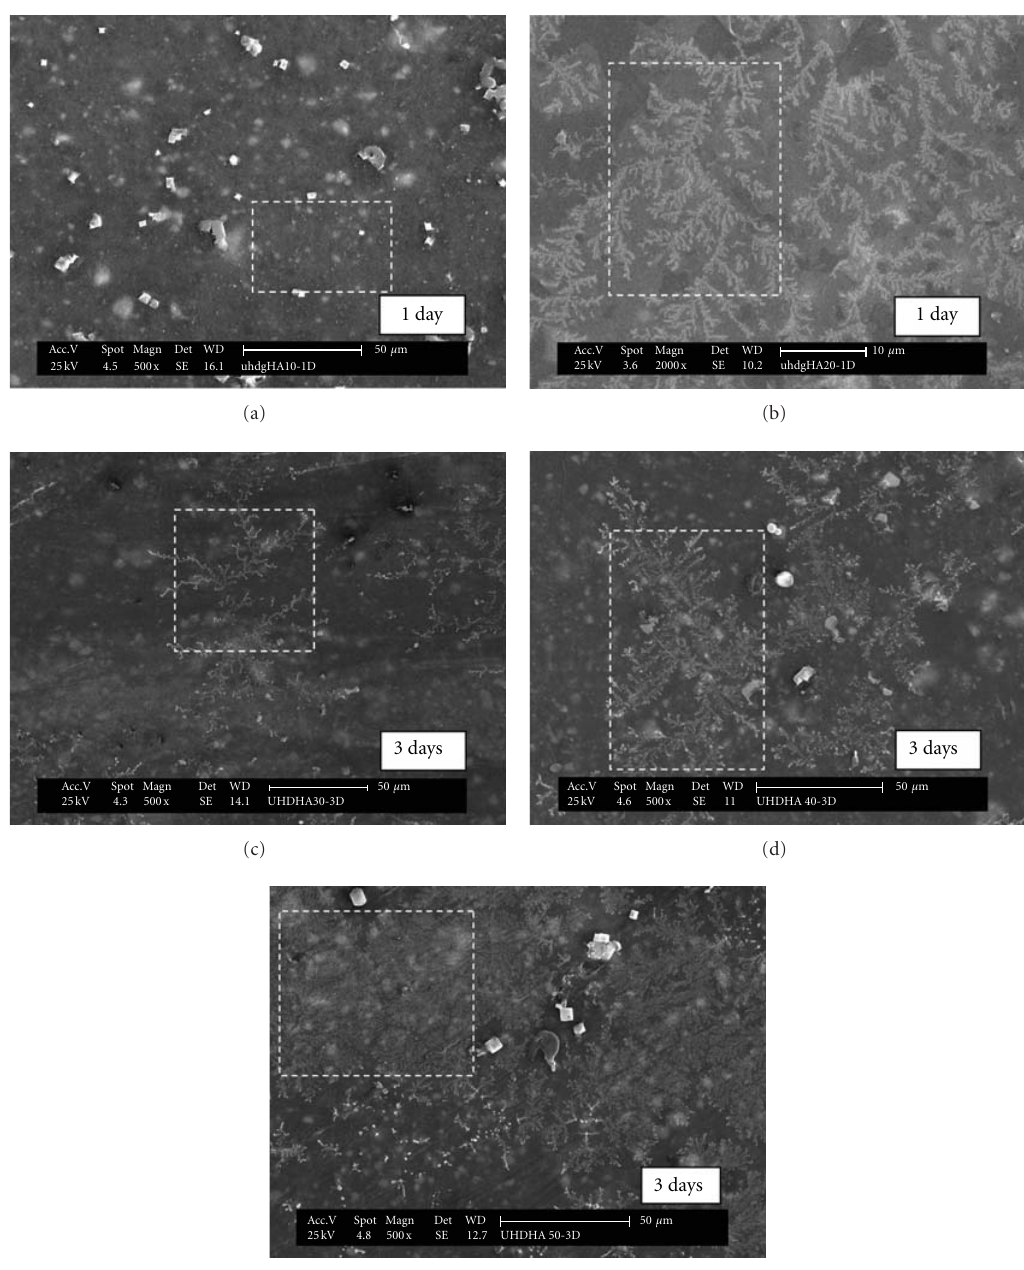
Figure 8: Apatite formation on UHMWPE/HDPE/PEG/HA composites for (a) 10, (b) 20 (c) 30, (d) 40, and (e) 50phr HA content. The dashed box shows the area of the element